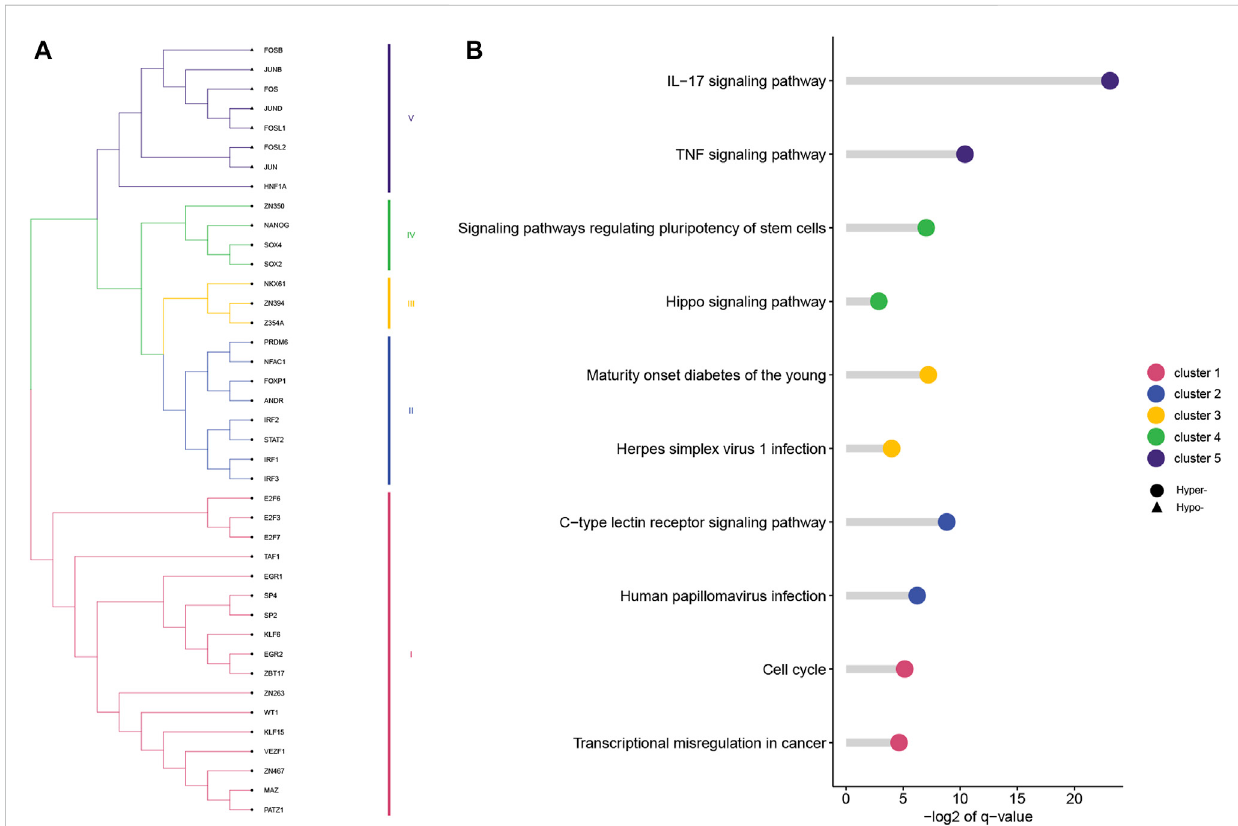
FIGURE 6 TFmotifsenrichedinhypermethylatedandhypomethylatedPDMPs. (A) TFmotifsweredividedinto fi veclustersbasedonthesequencesimilarity. (B) KEGG enrichment analysis of fi ve clusters. The top two enriched pathways of each cluster were